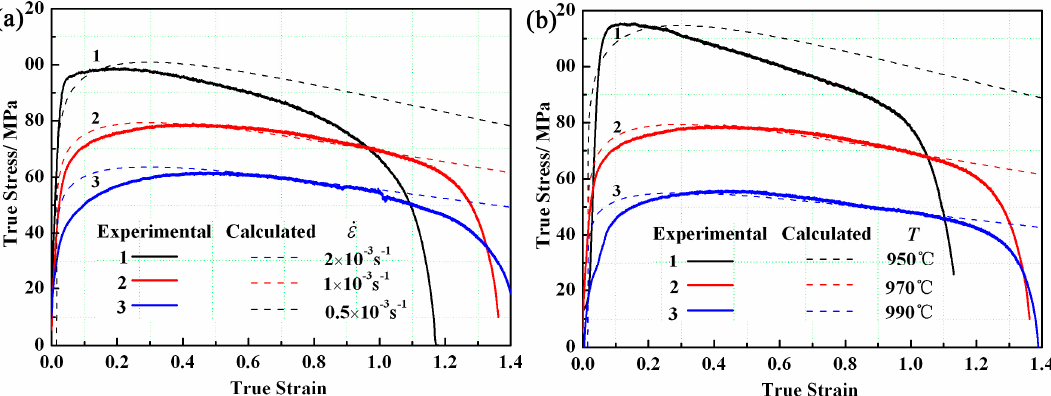
Figure 10. Comparison between experimental and calculated stress–strain curves: ( a ) different strain rates and T = 970 °C; ( b ) different temperatures and ε = 1.0 × 10 − 3 s − 1